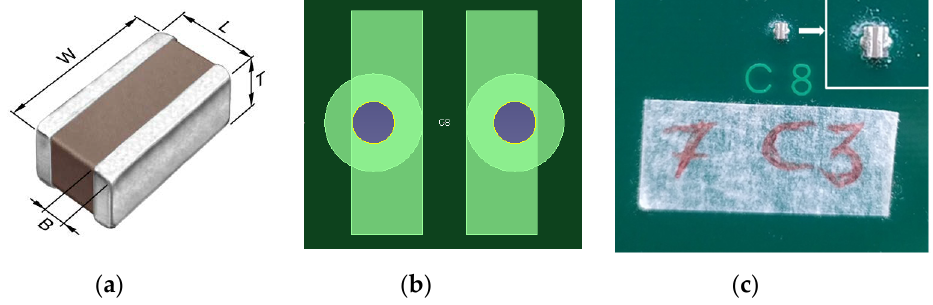
Figure 5. ( a ) Overview of the decap package with nominal dimensions B = 0.1 mm, T = 0.5 mm, W = 1.6 mm, L = 0.8 mm. ( b ) Layout for the decap with the pad on the top layer and the vias; ( c ) Placement of decap at location C8; the decap type C 3 is placed at the 7th iteration.